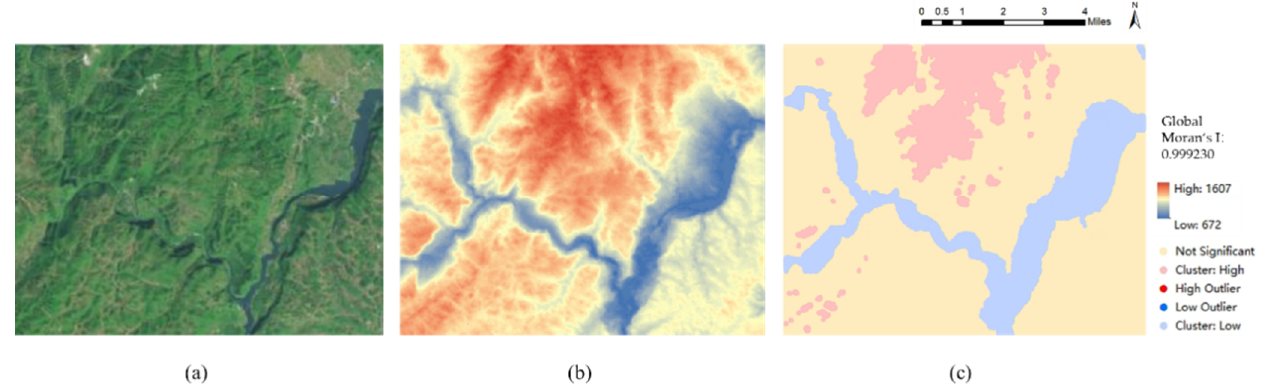
Figure 1. The elevation values of the terrain have spatial correlation: ( a ) is the remote sensing images of the region, ( b ) is the DEM of the region, and ( c ) is the LISA (local indicators of spatial association)